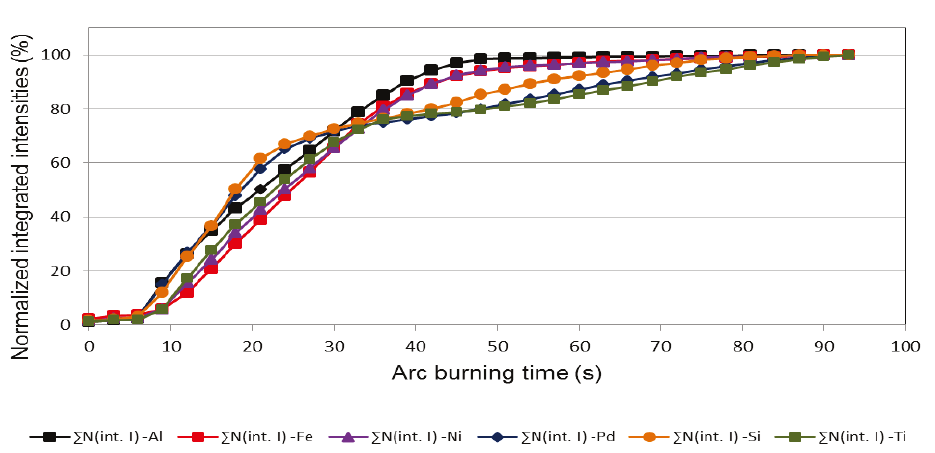
Figure 2. Time-scans of normalized integrated intensities in 90 s arcing time for the elements: Al ( λ =308.2 nm), Fe (273. 9 nm), Ni (345.8 nm), Pd (340.4 nm), Si (288.1 nm), Ti (336.1 Table 2. The data of the spectral lines (Al, Fe, Ni, Si, Ti, Pd) chosen during the method. Element/ionization E excitation (eV) state/wavelength (nm)